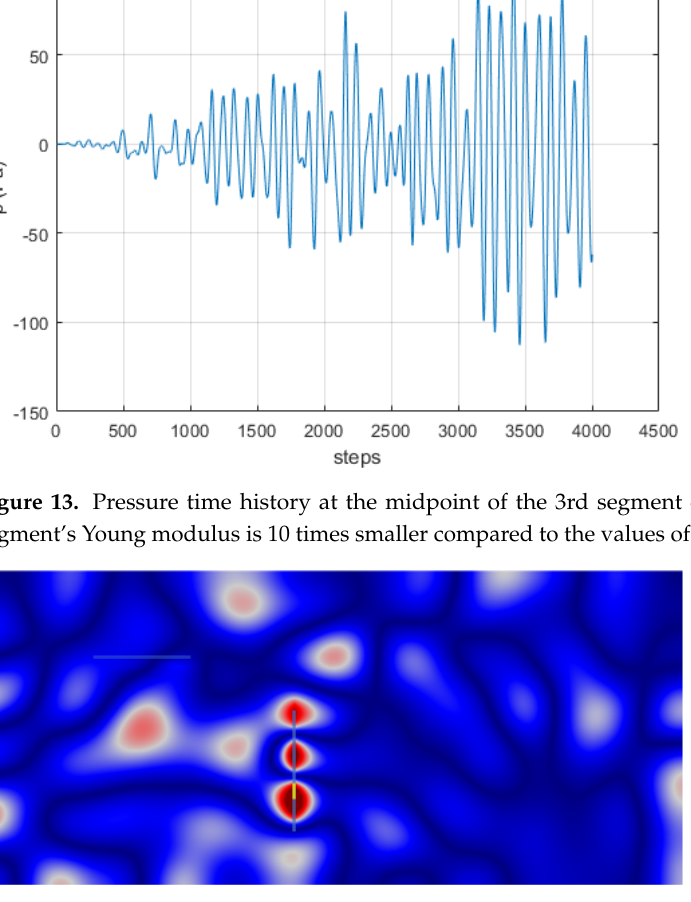
Figure 14. The absolute pressure on the whole domain at time 1.230ms. Beams are plotted with light blue color and the location of the defect is indicated with yellow color. Pressure activity is evident at the vicinity of the damaged segment of the